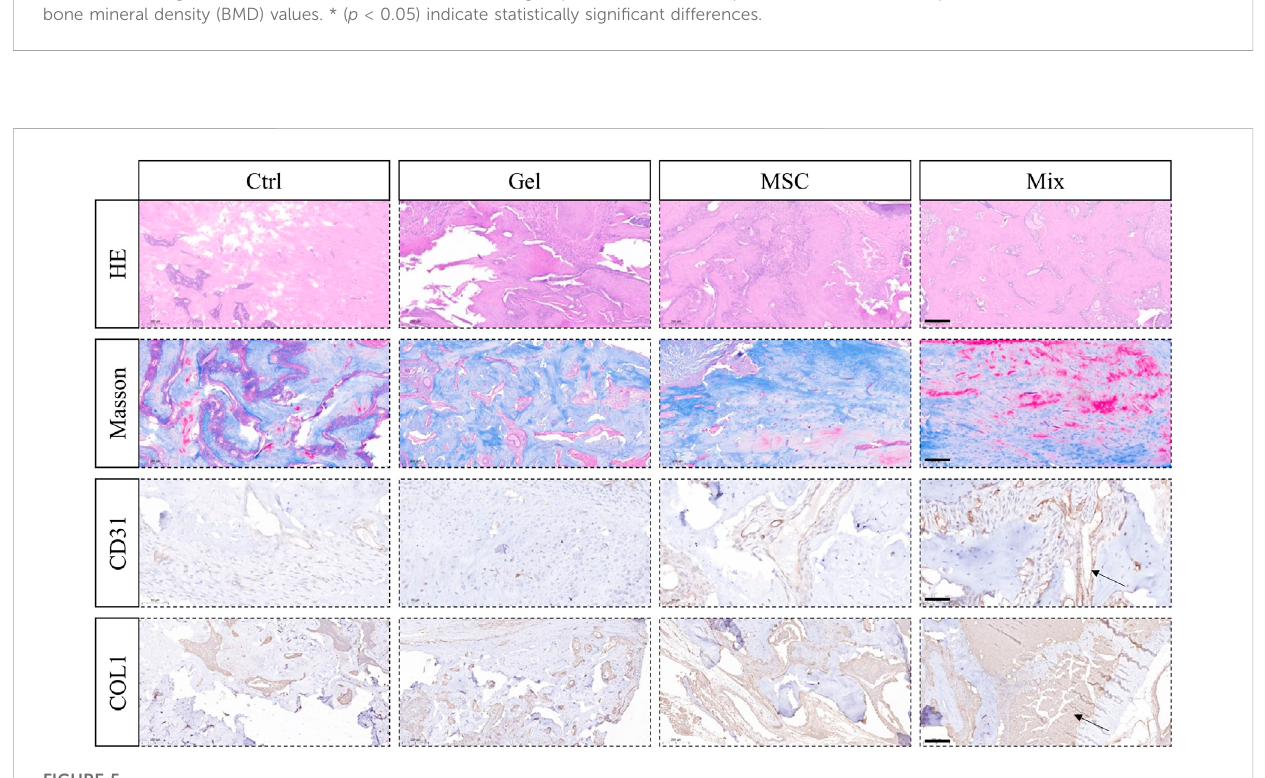
FIGURE 5 HE and Masson staining showing the trabeculae structure and collagen forming in the tooth sockets; Immunohistochemical staining of angiogenic marker CD31 and osteogenic marker COL1 in order to observe angiogenesis and osteogenesis effects. Scale bar: 200 μ m (HE, Masson, COL1); 50 μ m (CD31). The arrow sign: positive expression